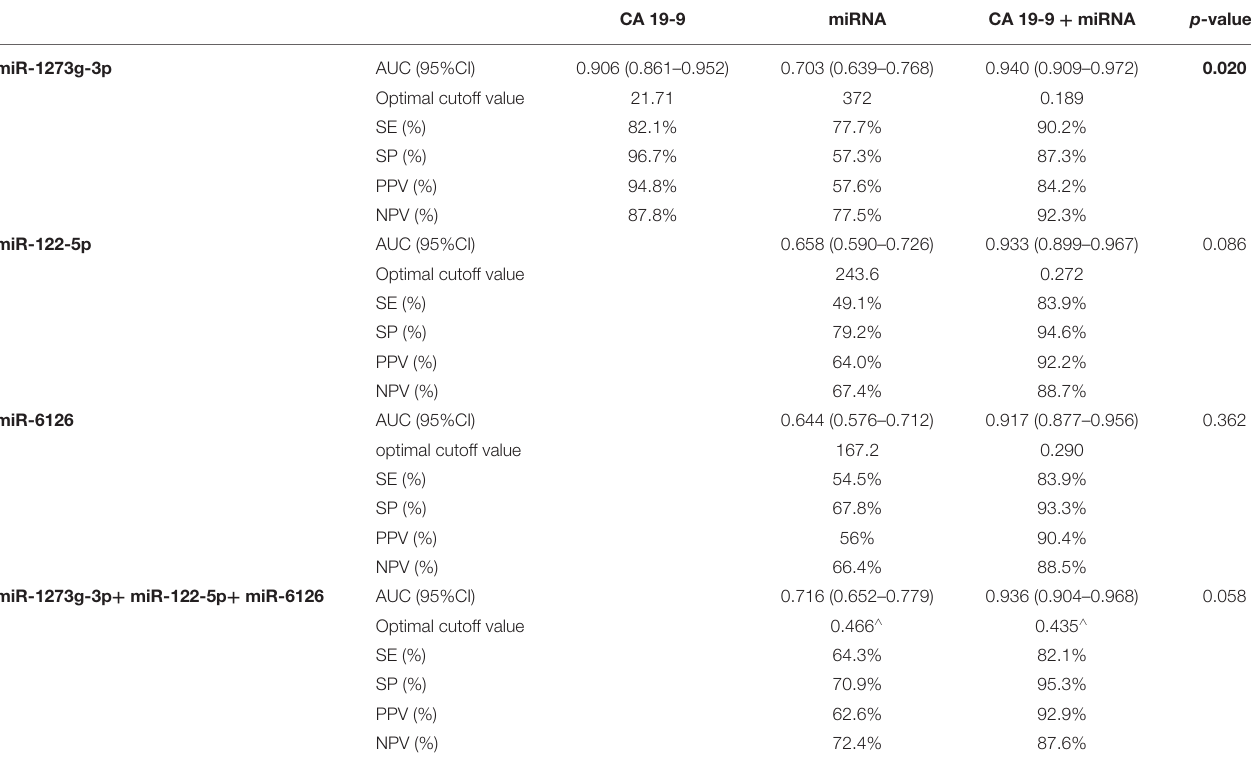
TABLE 3 | Diagnostic performance achieved by a receiver operating characteristic (ROC) curve analysis for miR-1273g-3p, miR-122-5p and miR-6126 compared to serum CA 19-9 determination in distinguishing patients with pancreatic cancer from healthy subjects.